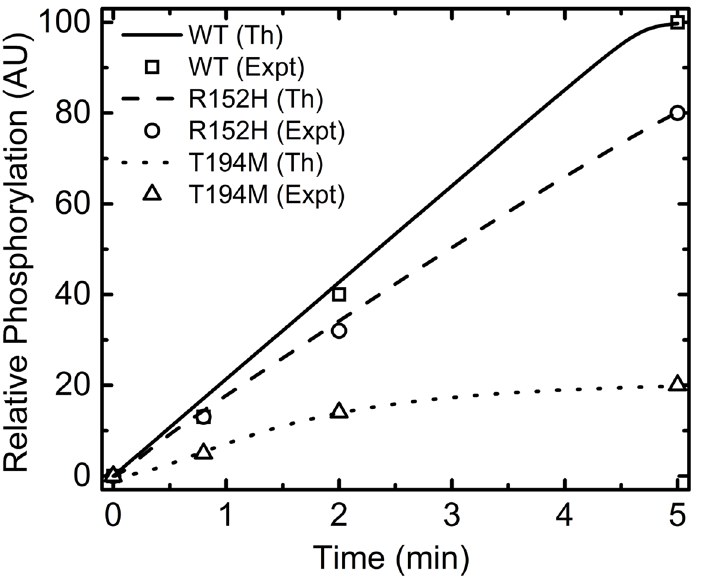
Fig 4. In vitro phosphorylation assay. Profiles of in vitro phosphorylation assay generated using stochastic optimization. The solid, dashed and dotted lines are for WT, R152H and T194M, respectively. The symbols are experimental results due to Jones el al. [24]. In the figure legend Th and Expt stand for theoretical and experimental data, respectively.